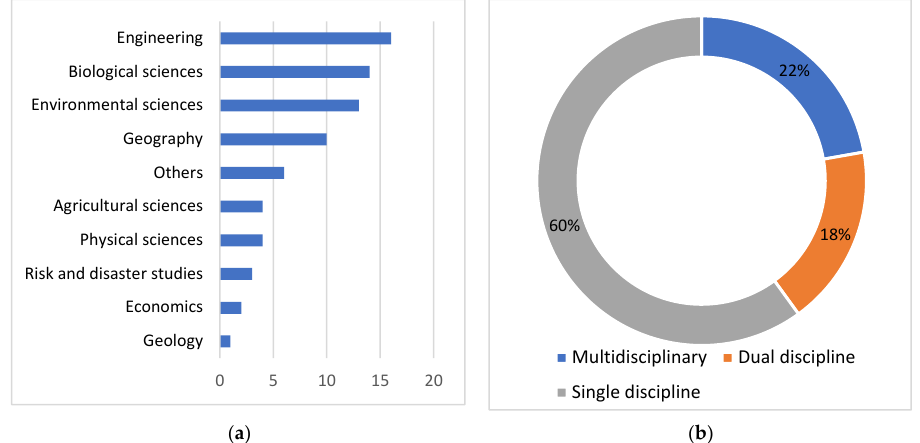
Figure 5. Distribution of studies by ( a ) disciplines and ( b ) interdisciplinarity.